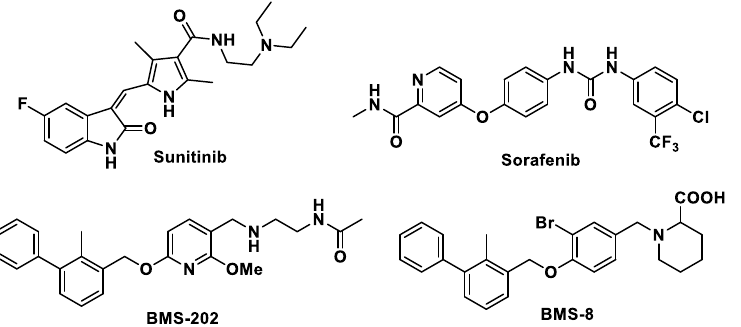
Figure 1. Structures of vascular endothelial growth factor-2 (VEGFR-2) inhibitors sunitinib and sorafenib and anti-programmed death-ligand-1 (PD-L1) agents BMS-202 and BMS-8.